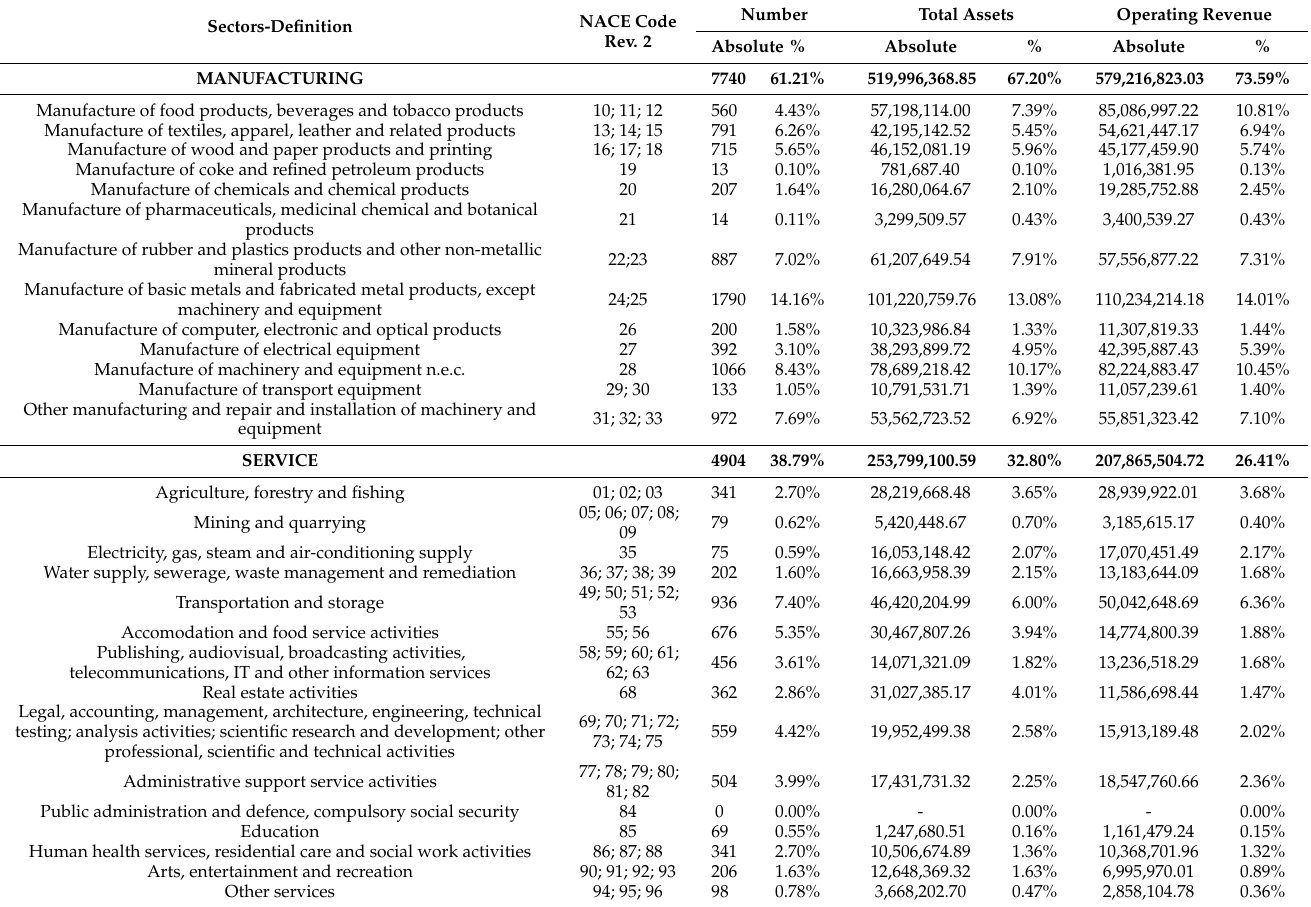
Table 2. Number of firms and key financial data by